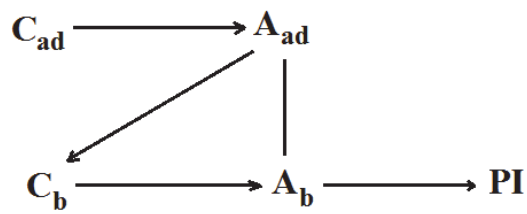
Fig. 1. Dual Mediation Hypothesis Model of Ad